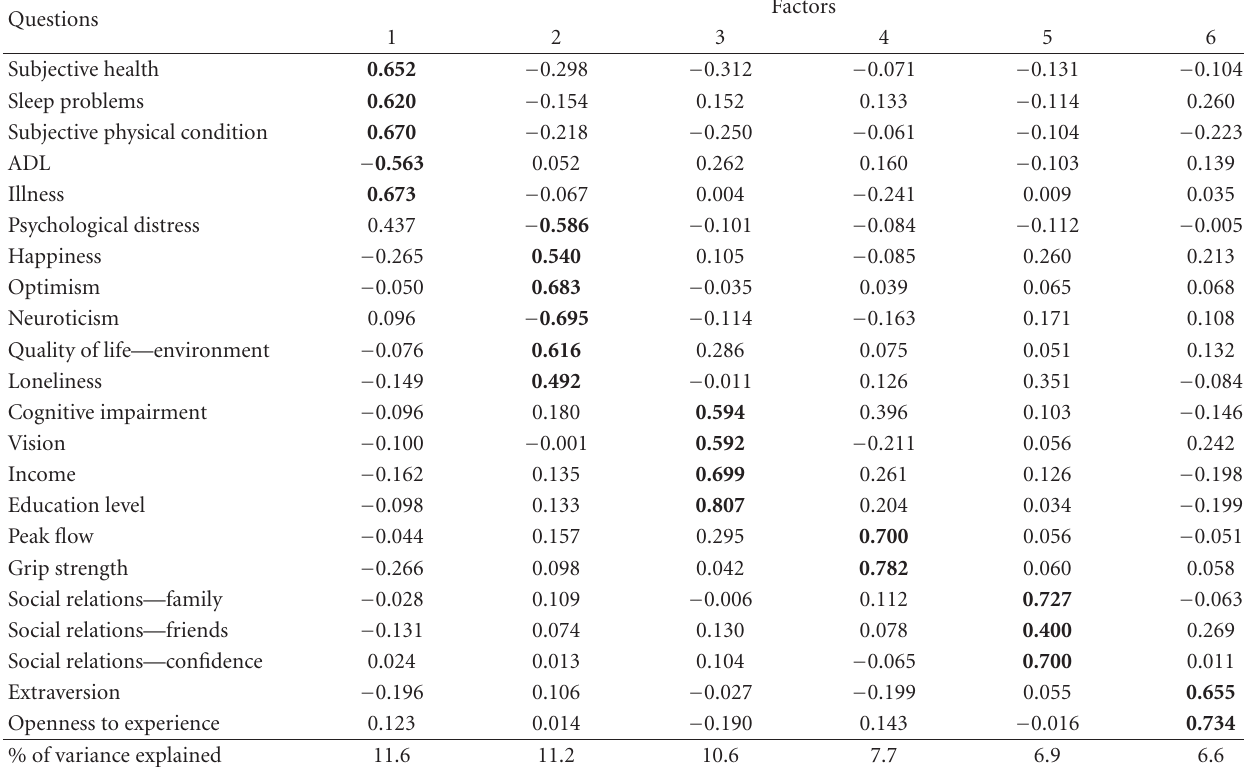
Table 3: Factor structure of P3A—exploratory factor analysis.